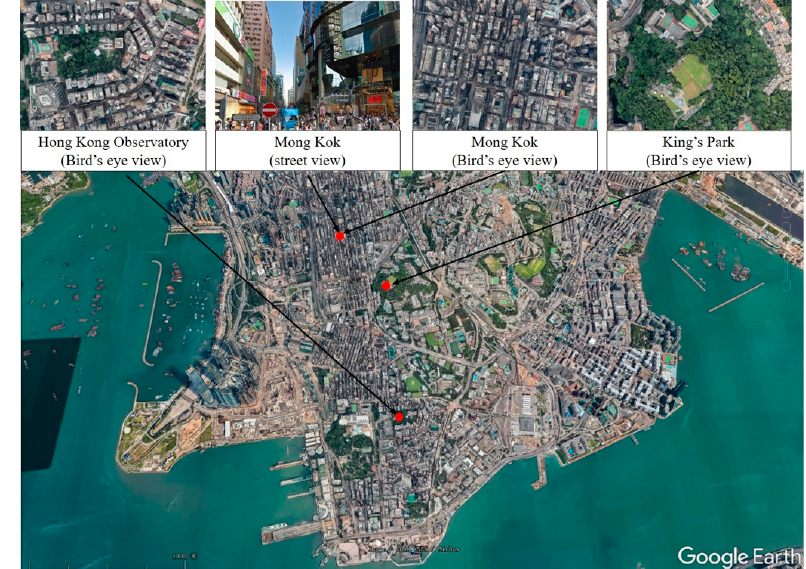
Figure 1. The Kowloon Peninsula of Hong Kong, the bird’s eye view and street view of Mong Kok and associated weather stations (Hong Kong Observatory and King’s Park stations). Bird’s eye view pictures are from google map.